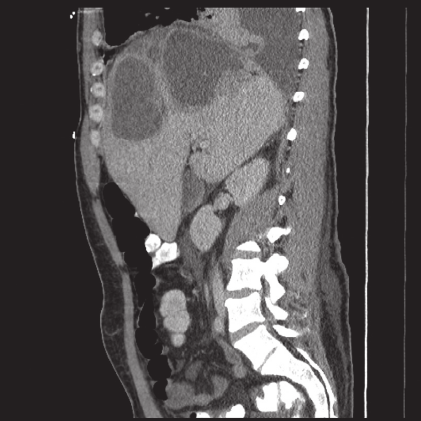
Figure 1: CT chest/abdomen/pelvis with contrast, sagittal view, obtained on hospital day 1 showing large hepatic